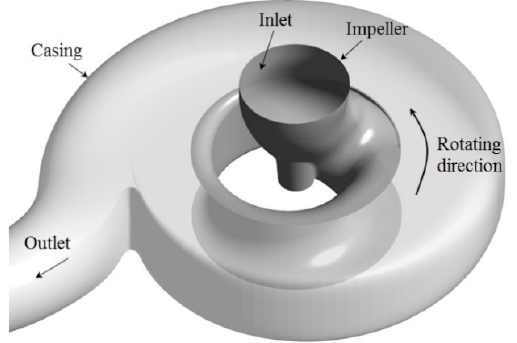
Figure 1. Geometry of single-channel pump.